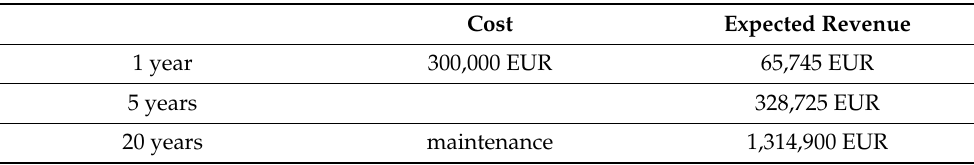
Table 1. Cost and benefit of micro-hydro power plant